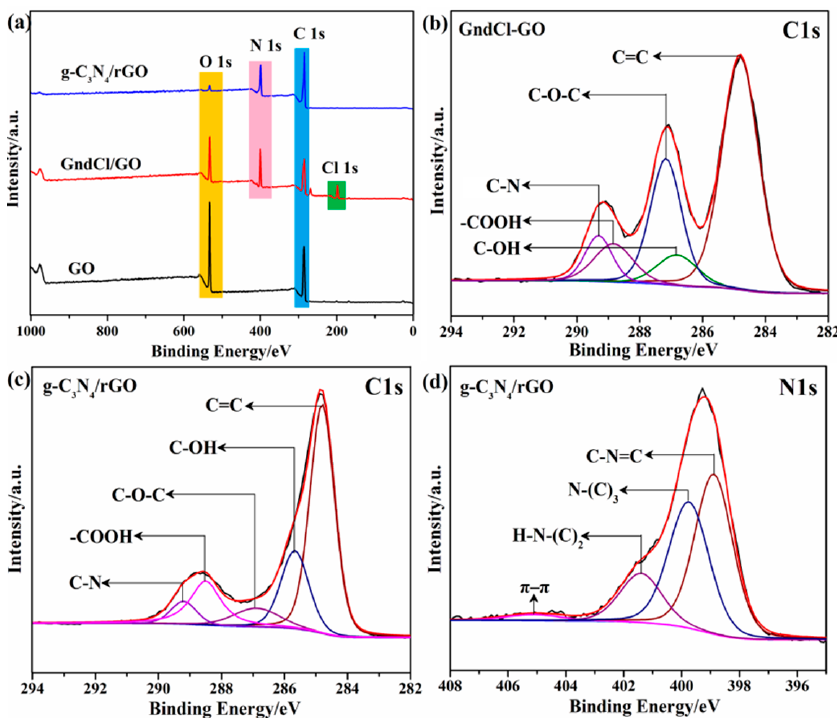
Figure 3. ( a ) XPS survey spectra of the GO, GndCl/GO and g-C 3 N 4 /rGO nanocomposite. ( b ) High resolution C 1s spectra of GndCl/GO precursor. High resolution C 1s ( c ) and N 1s ( d ) spectra of the g-C 3 N 4 /rGO nanocomposite. Table 2. C species content (at%) of the sample according to XPS analysis from Figure